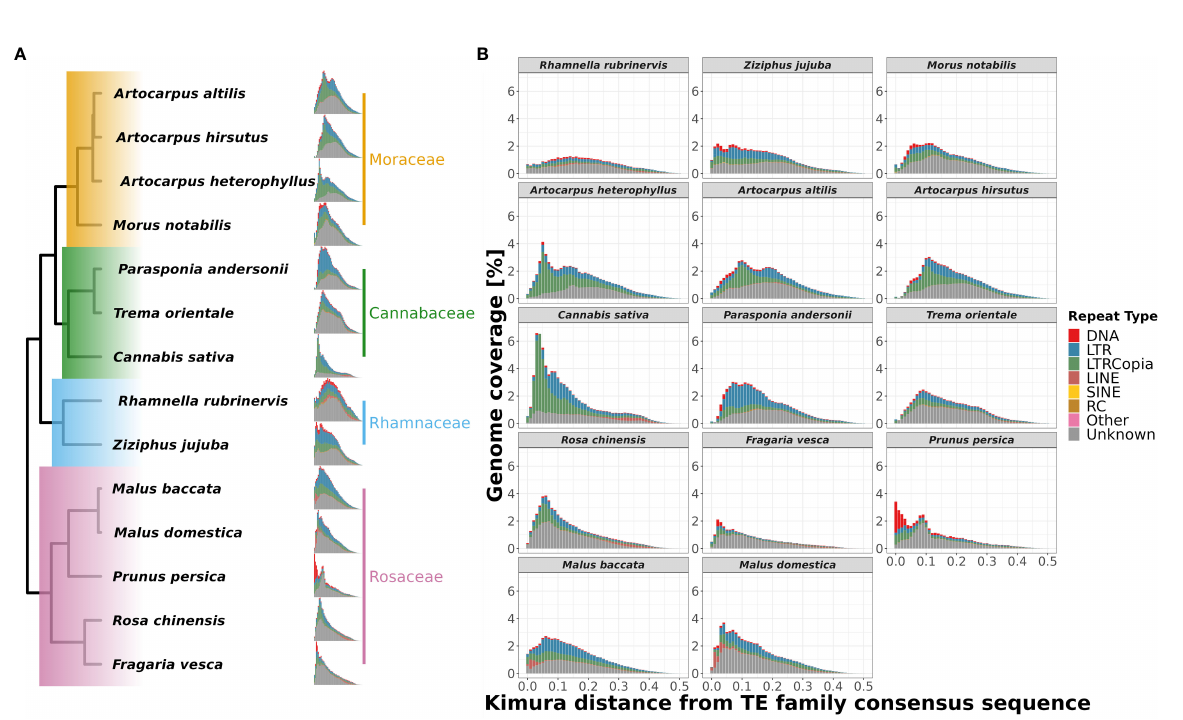
FIGURE 6 Repeat landscape evolution in 14 species of order Rosales. Family-wise changes in repeat landscapes: (A) The differences in abundance and insertion ages of repeat families are depicted phylogenetically. The recent spike in the fraction of the genome covered by repeats of A. heterophyllus suggests a recent accumulation not shared by the other two species of Artocarpus . (B) Repeat landscapes for 14 species of order Rosales showing the distribution of different repeat types and their ages of insertions depicted by Kimura distance (along the x-axis) and Genome coverage (along y-axis) percentages. A. heterophyllus shows a peak (3.5% of genome coverage) of LTR-Copia abundance during the recent period (~0.05 Kimura distance), which is not shared by the other two species as they have a peak (~2.5% of genome coverage) during the comparatively older period (~0.1 Kimura